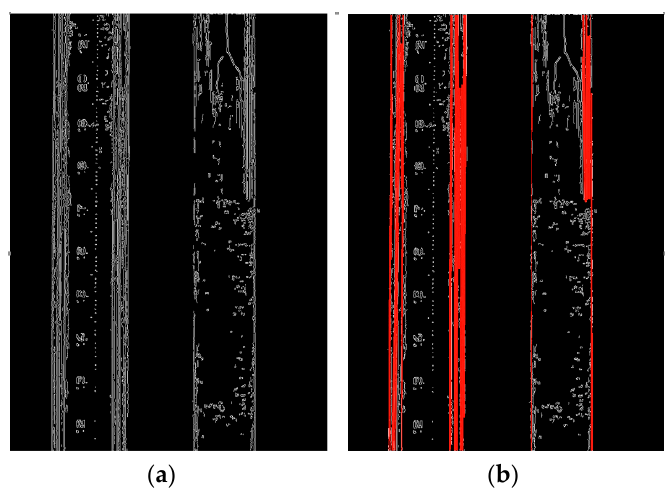
Figure 8. ( a ) Improved edge and ( b ) Hough linear detection.